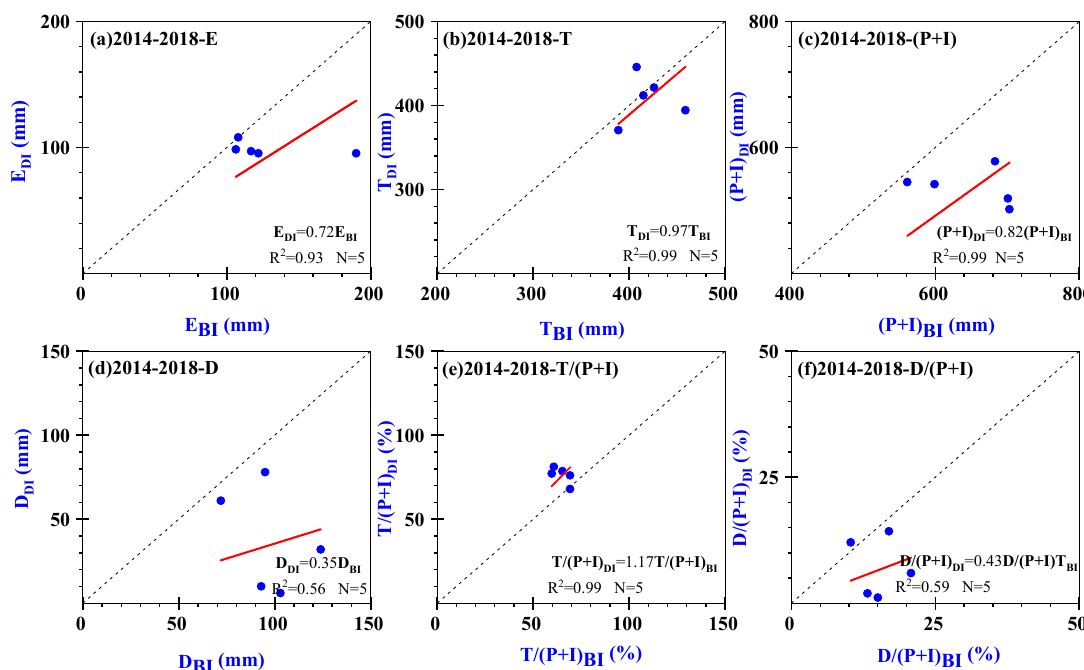
Figure 6. Comparison of evaporation (E), transpiration (T), drainage (D), P+I, D/(P+I) and effective water utilization (T/(P+I)) under film mulching border irrigation (BI) treatment film mulching drip irrigation (DI) treatment during 2014–2018.